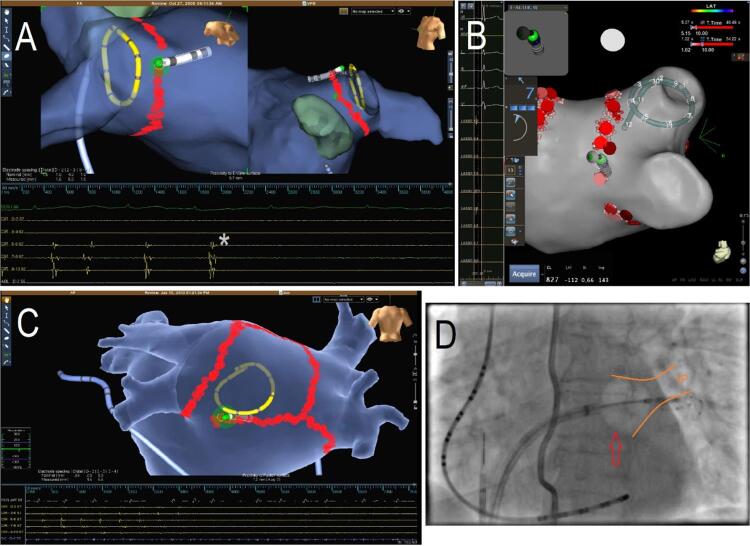
– Catheter ablation for the treatment of paroxysmal AF. A) Isolation of left VPs by circumferential ablation (RF point-by-point) guided by 3D electroanatomic mapping (NAVx system — Abbott), demonstrating the elimination of electrograms (*) recorded by a circular catheter inside the PVs. B) Isolation of the right PVs (CARTO system — Biosense Webster) with a contact force-sensing catheter (shown by the force vector and force quantification = 7 g); the circular mapping catheter is inside the right superior PV. C) Persistent AF ablation (NAVx system — Abbott) demonstrating the additional linear RF lesions to isolate the LA posterior wall (roof and inferior lines), leading to the elimination of electrograms (recorded by the circular mapping catheter). D) Fluoroscopic imaging during cryoablation for isolation of the left superior PV, demonstrating the balloon catheter (arrow) inflated and in contact with the vein ostium. Balloon ablation along the PV circumference is performed simultaneously, which is usually restricted to PV isolation — when additional ablation is required, an RF catheter should be used.